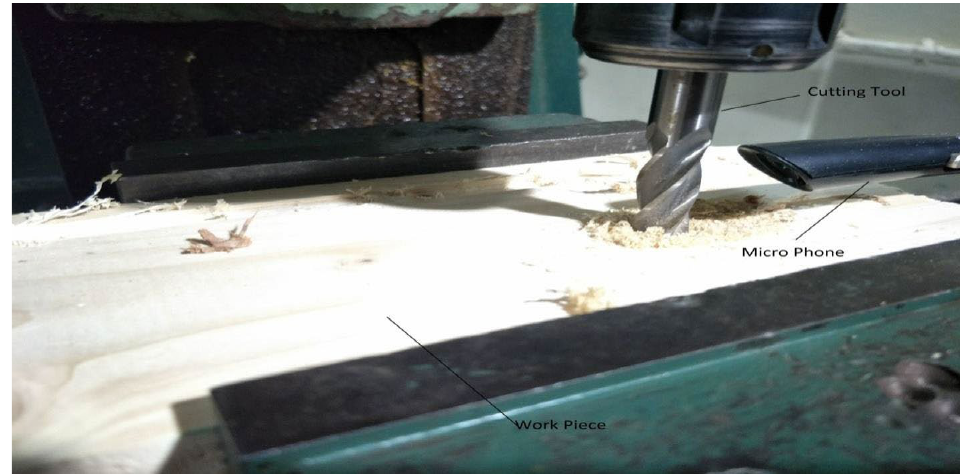
Figure 4. Experimental setup.